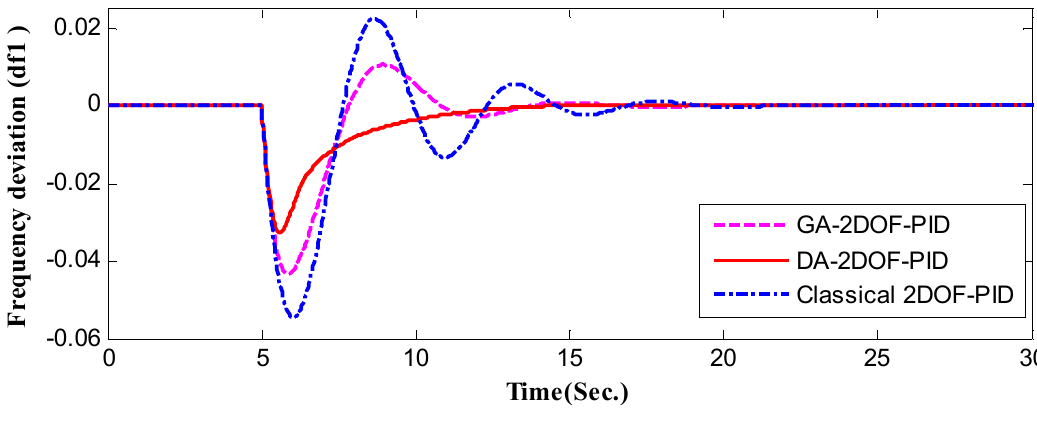
Figure 21. Δf (cid:2869) , using GA-2DOF-PID, DA-2DOF-PID, and classical-2DOF-PID with ITAE.